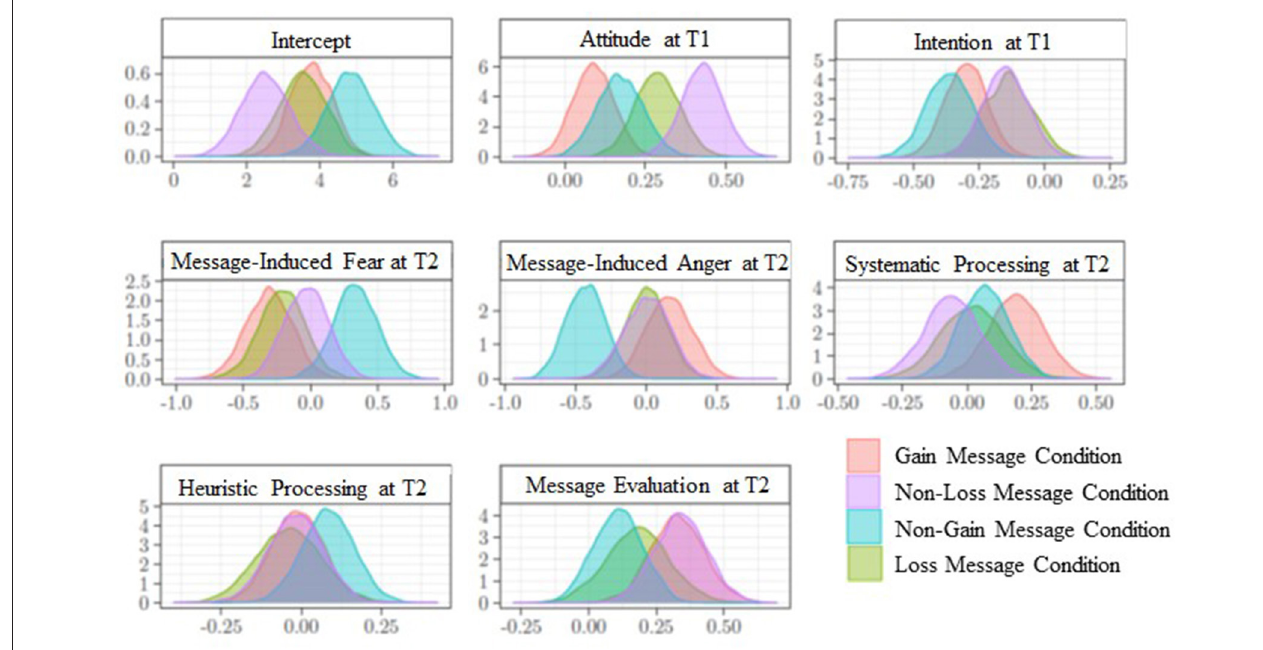
FIGURE 4 | Attitude at time 2. Posterior distributions of the parameters associated with predictors, according to message